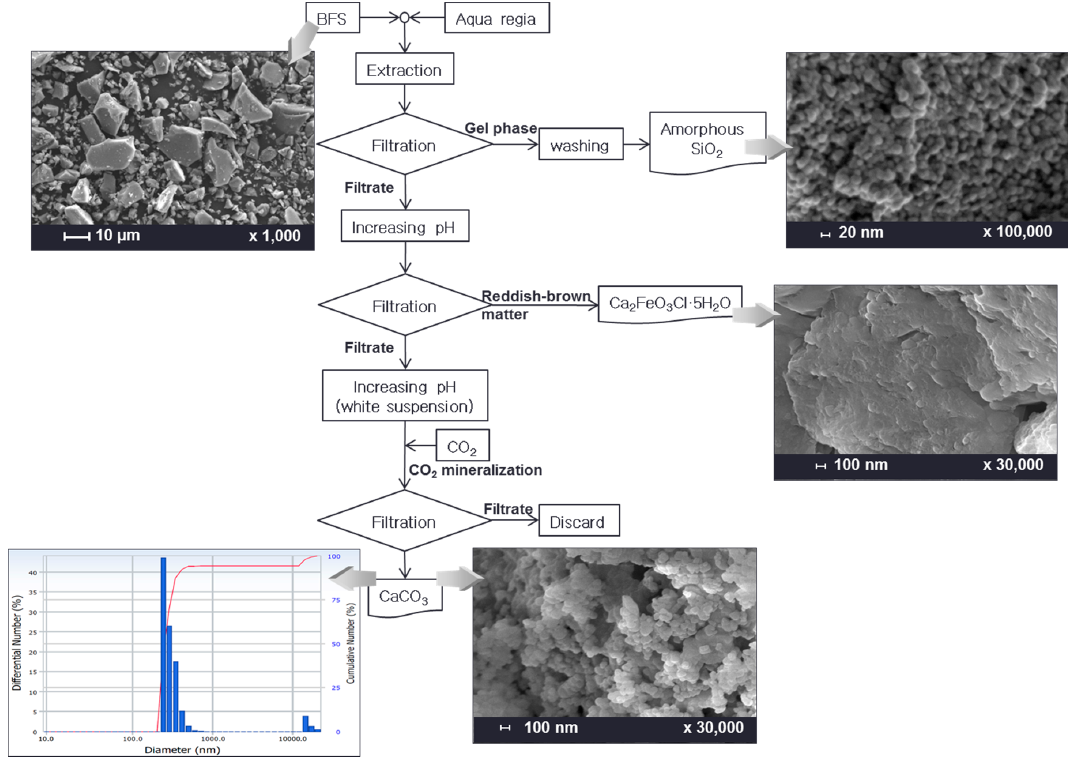
Figure 1. Experimental procedures and SEM images of BFS and precipitates.